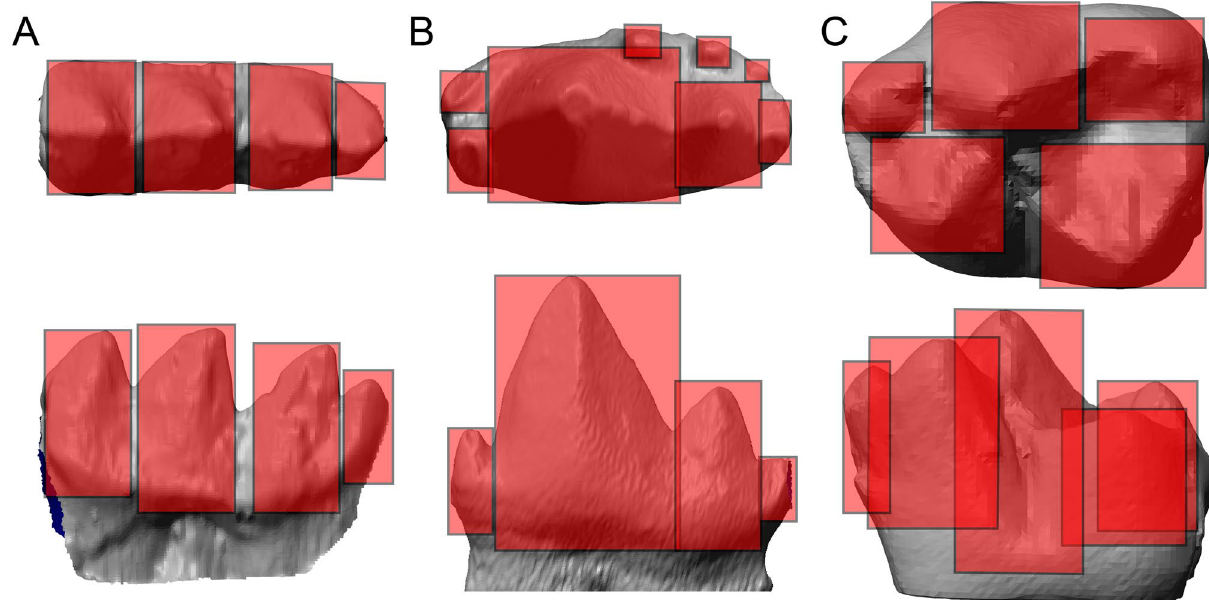
Figure 5. Comparative patterns of molar cusp size and height of Triconodontidae, relative to mammaliaforms and other mammals. ( A ) Derived triconodontid; ( B ) plesiomorphic triconodont molar of Morganucodon (UMZC Eo.CR1); and C, a tribosphenic molar of Cantius ralstoni (USGS 13634) in occlusal and lingual view. Squares are plotted over individual cusps to highlight them as functional units. It is apparent that